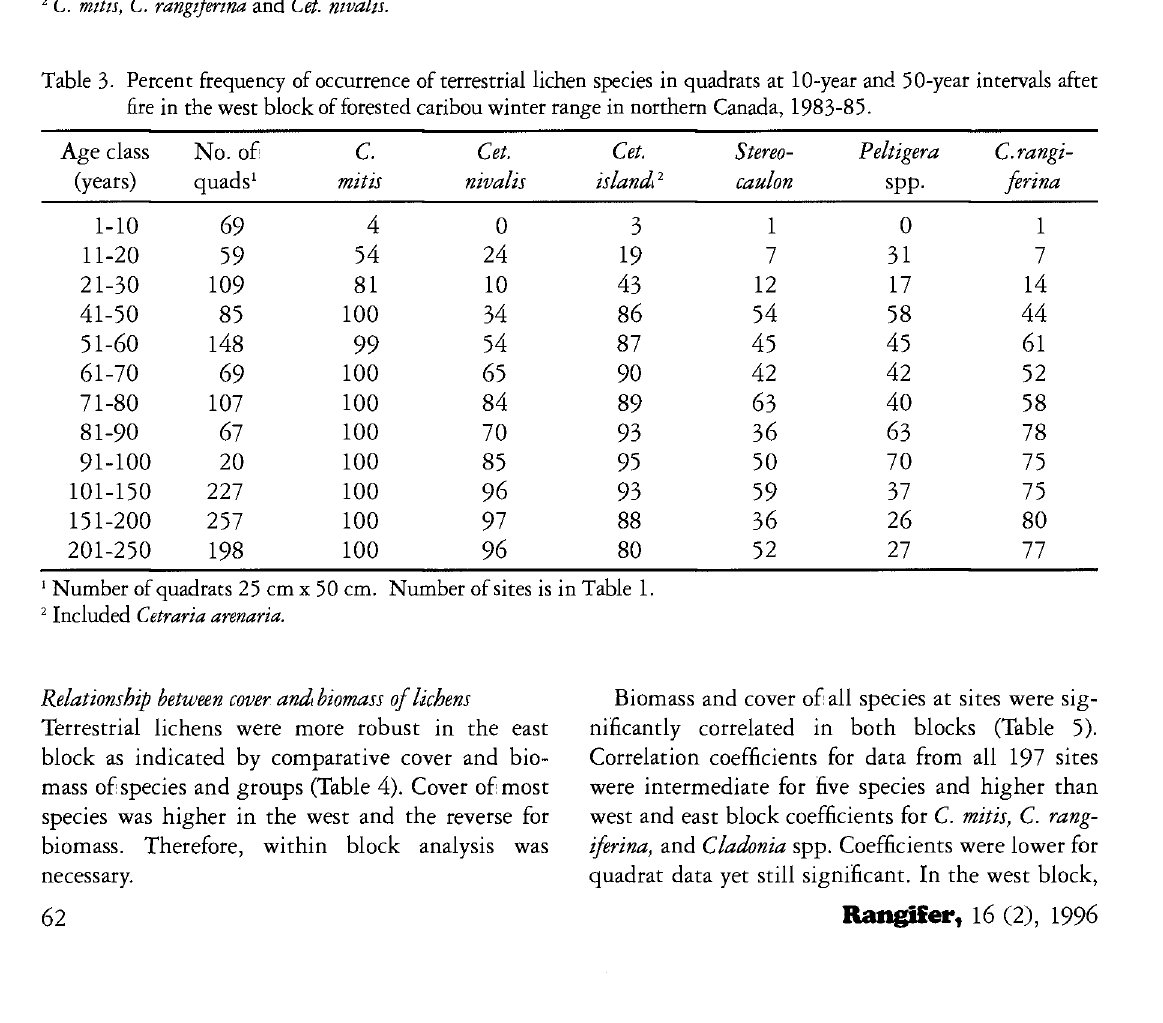
151-200 201-250